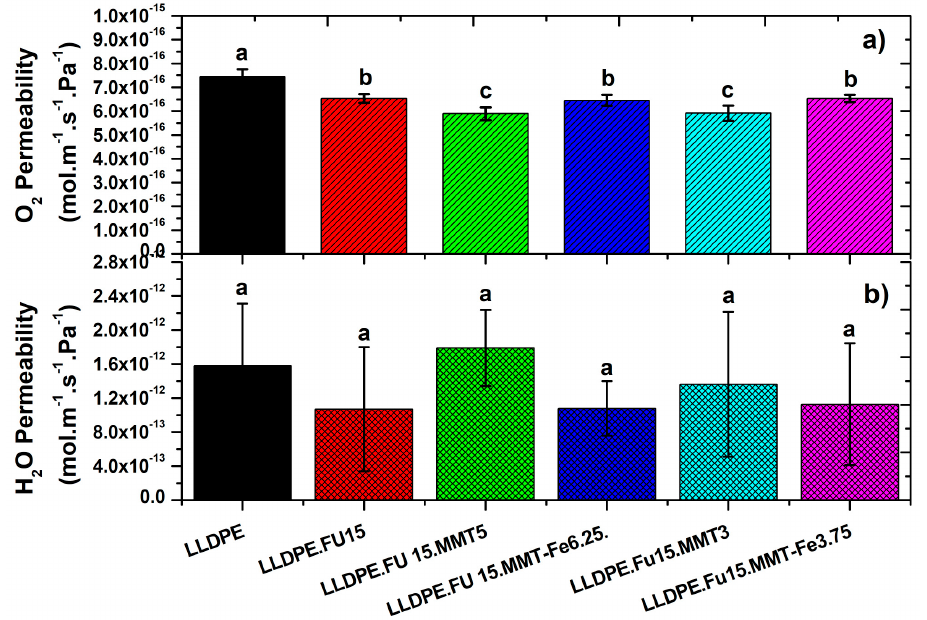
Figure 7. ( a ) Oxygen permeability and ( b ) water vapor permeability of ( a ) LLDPE film and LLDPE with compatibilizer and active films containing MMT-Fe with different contents (3.75% or 6.25%). The data are reported as mean ± standard deviation of four replicates. Bars with different letters represent significant difference (ANOVA test, p -value ≤ 0.05). Raw data corresponding to this figure has been uploaded at https://doi.org/10.5281/zenodo.3253103.